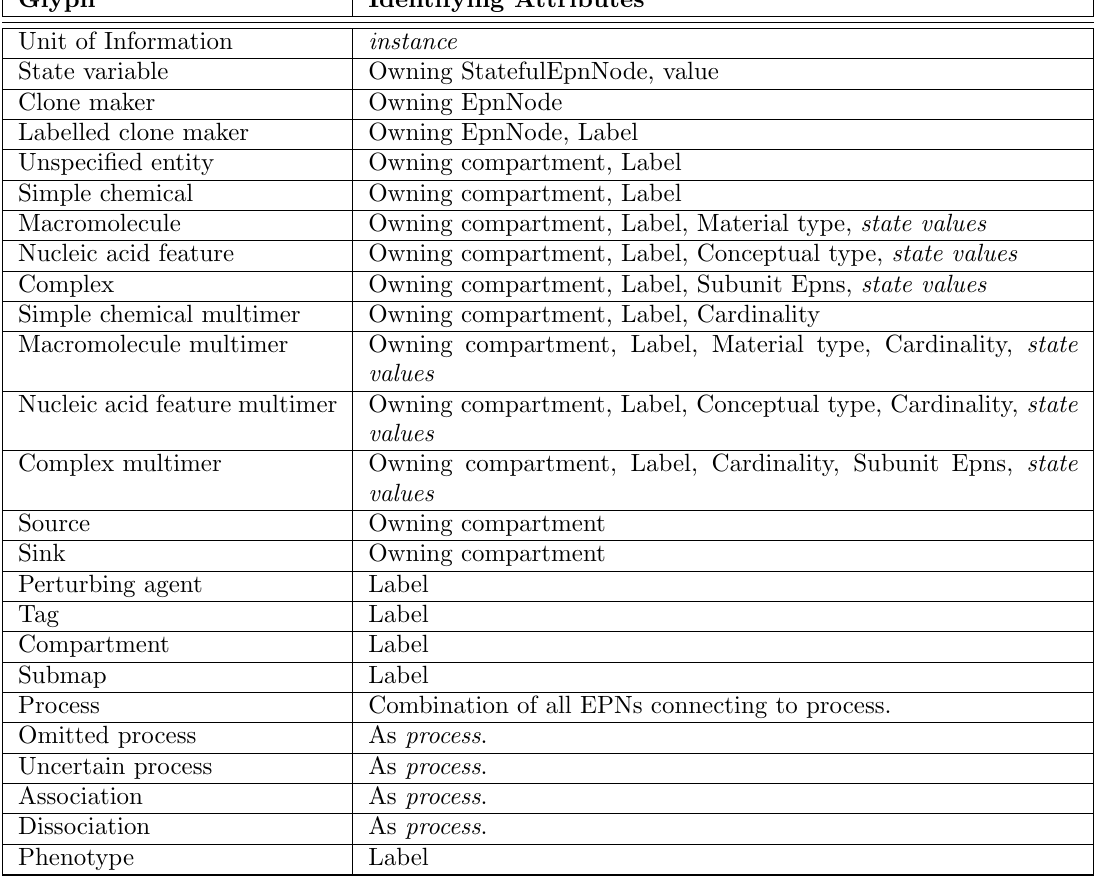
Table 3.1: The Identifying attributes of Process Description node glyphs. When a glyph is always unique in a map, this is indicated by the term instance . The term state values indicates that the values of all the EPN’s state variables are used in the definition of its